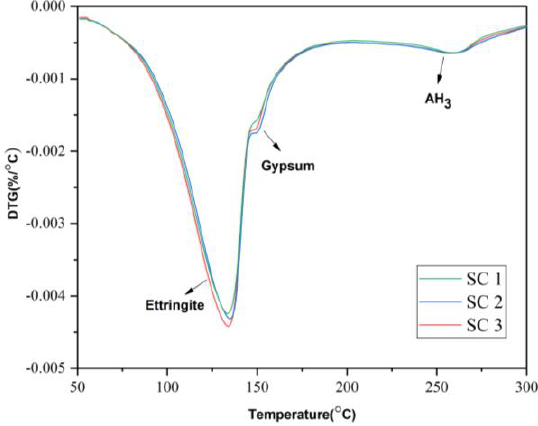
Figure 8. DTG curves of samples SC1-SC3 at 3 days of age.